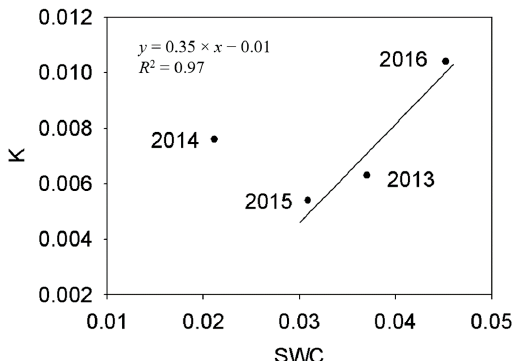
Figure 4. Relationship between annual mean volumetric soil water content (SWC) and transpiration sensitivity to VPD (K) from 2013 to 2016. Transpiration sensitivity to VPD (K) was defined as the slope of linear regression between daily T r and VPD. The data were fitted with a linear function between K and annual average SWC at SWC > 3%.